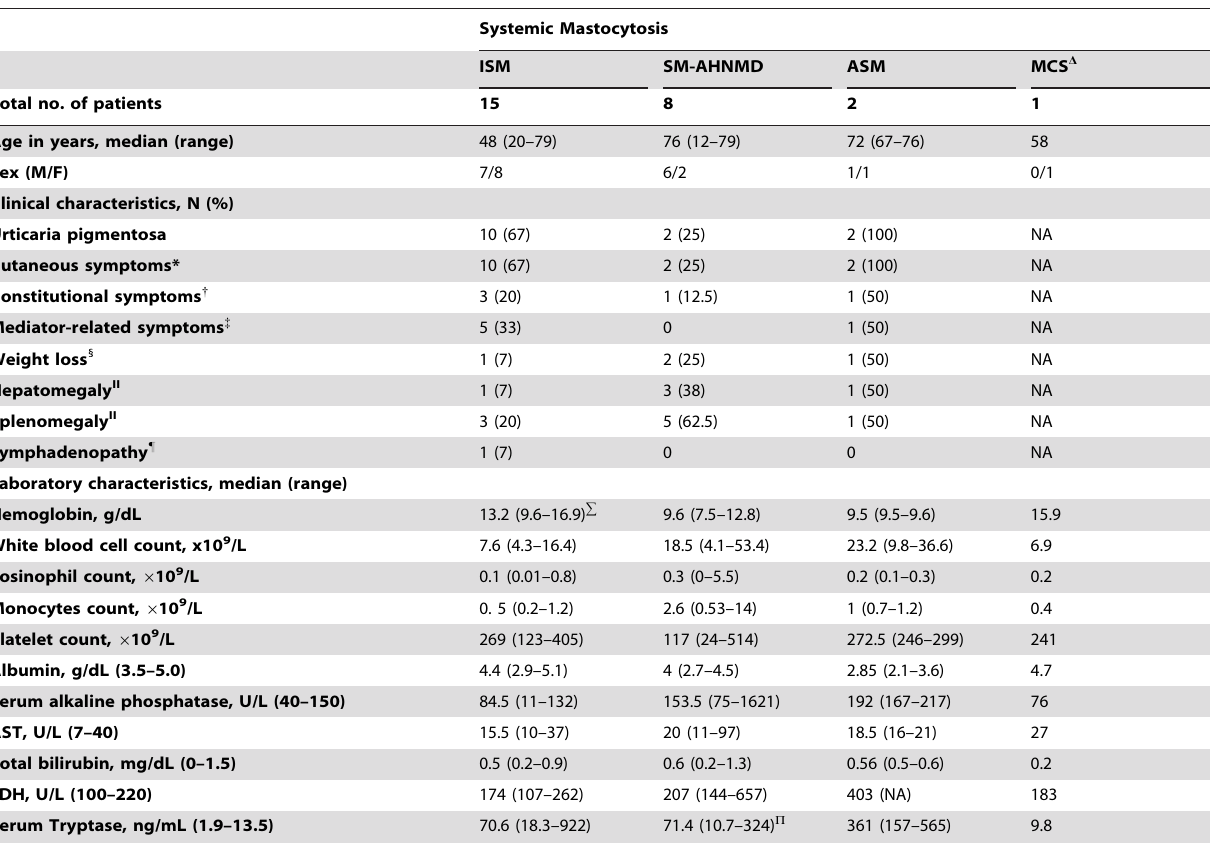
Table 1. Clinical and laboratory characteristics of mastocytosis